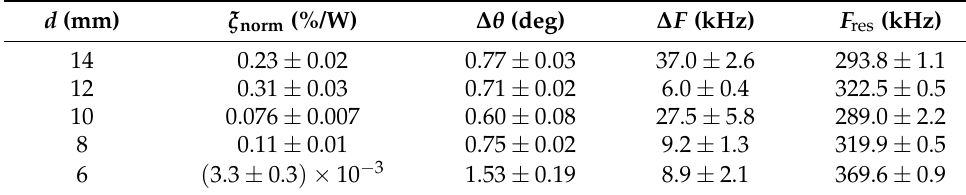
Table 1. Properties of AO modulator of THz radiation revealed in the